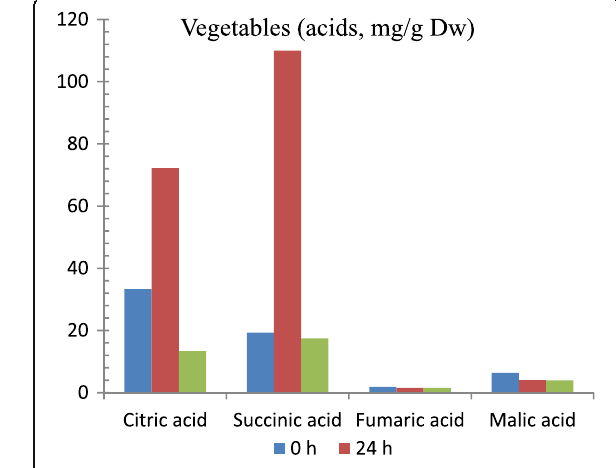
Fig. 1 Average values of organic acids of all the analyzed cereals Fig. 3 Average values of organic acids for all the analyzed